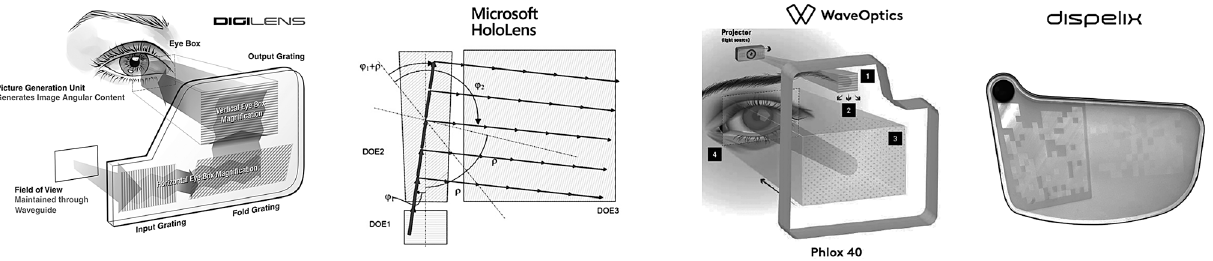
Figure 9: 2D pupil replication architectures in planar optical waveguide